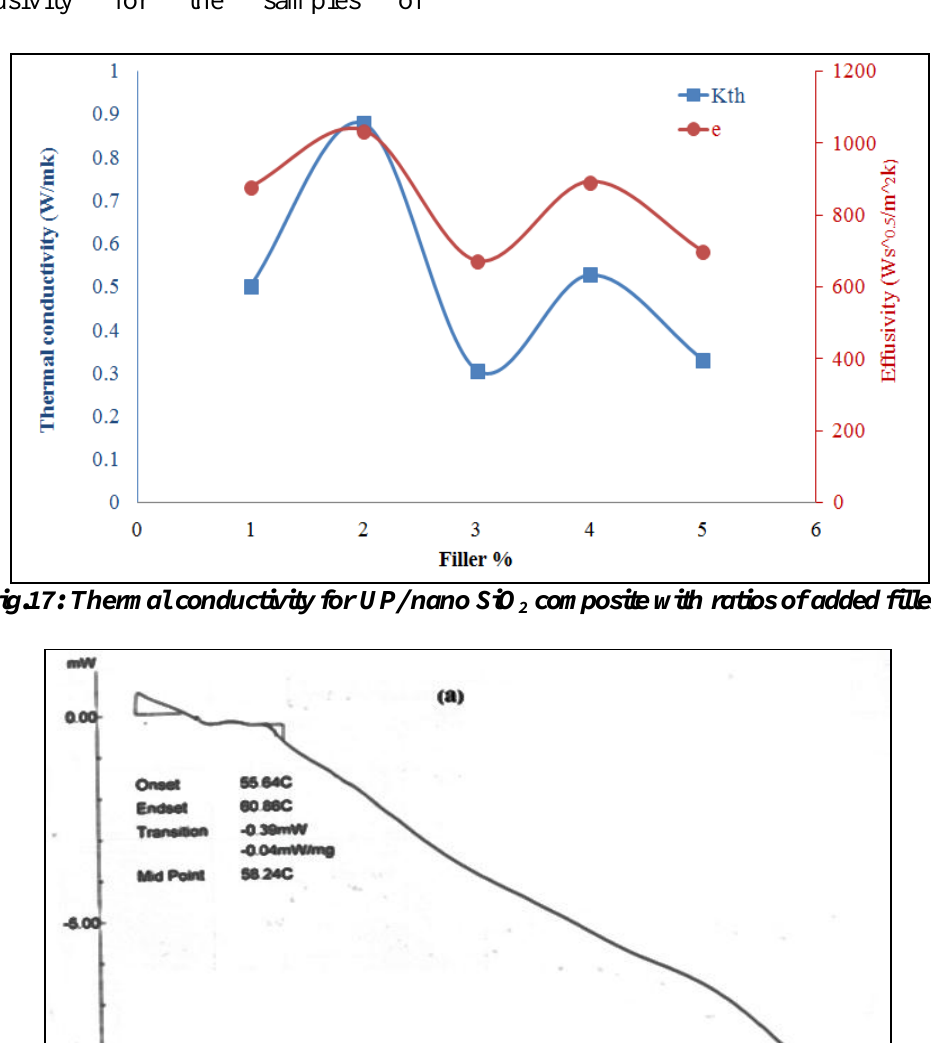
composite at X= 2